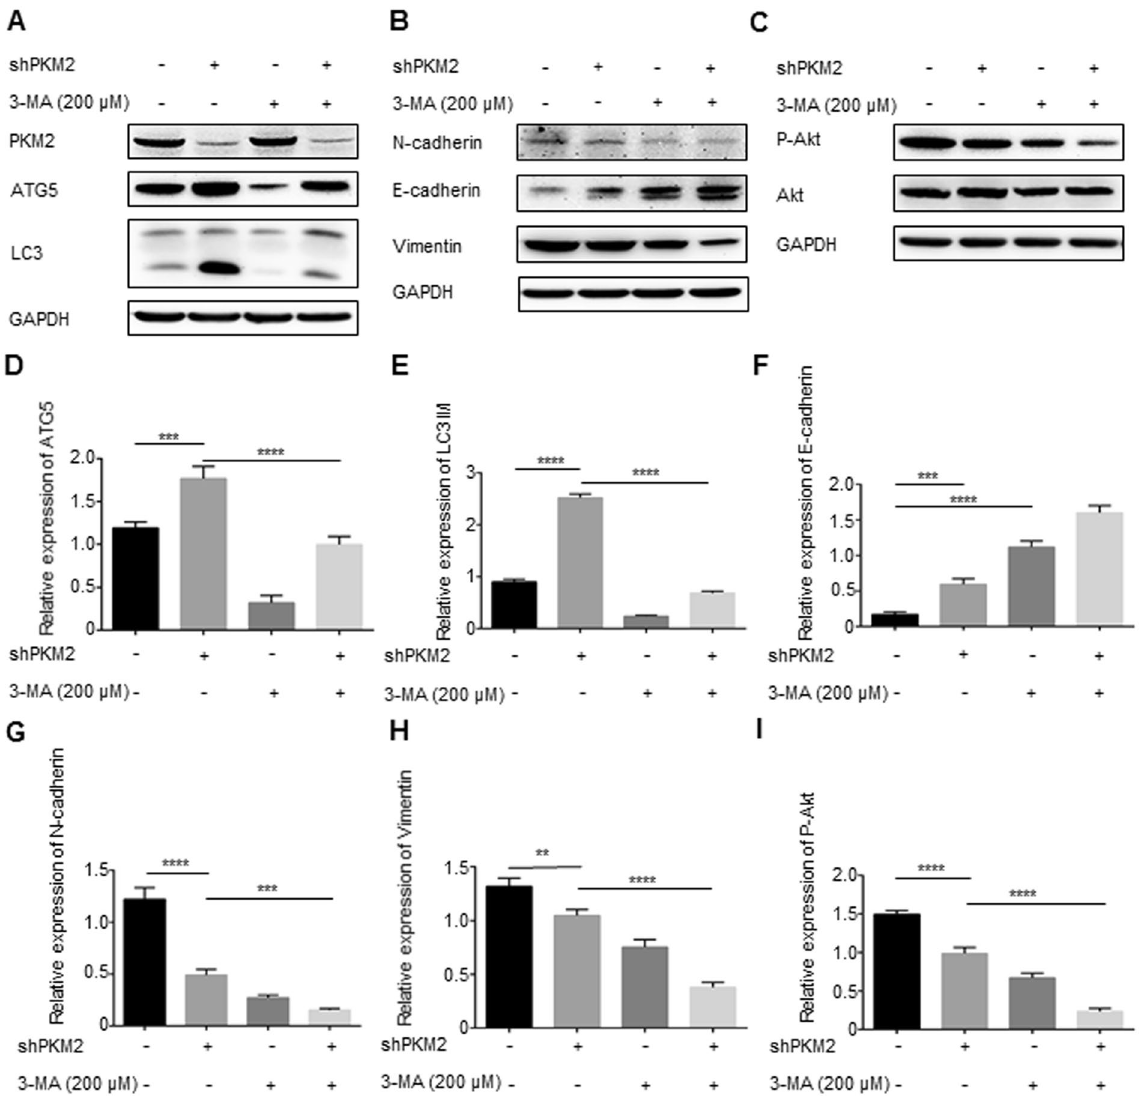
Figure 6. PKM2 mediates cell migration and autophagy via the PI3K/Akt signaling pathway. ( A ) Western blot analysis of PKM2, ATG5 and LC3 in NCI-N87 cells treated with knockdown of PKM2 in the presence of 3-MA (200 μ M) for 24 h. ( B ) NCI-N87 cells were transducted with PKM2 shRNA and then treated with 200 μ M 3-MA for 24 h, the expression levels of N-cadherin, E-cadherin and Vimentin were analyzed by western blot. ( C ) NCI- N87 cells were transducted with PKM2 shRNA and then treated with 200 μ M 3-MA for 24 h. Cell lysates were prepared and subjected to western blot analysis using monoclonal anti-Akt and anti-phospho-Akt antibody. Full-length gels and blots are presented in the Supplementary files 2. ( D – I ) Relative expression of ATG5, LC3 II/I, E-cadherin, N-cadherin, Vimentin and P-Akt, and the quantitative western blot analysis results obtained using densitometric analysis, which were standardized according to GAPDH and calculated by ImageJ software (NIH). The data represent the mean ( ± SD) from three independent experiments. ** P < 0.01. *** P < 0.001. **** P <